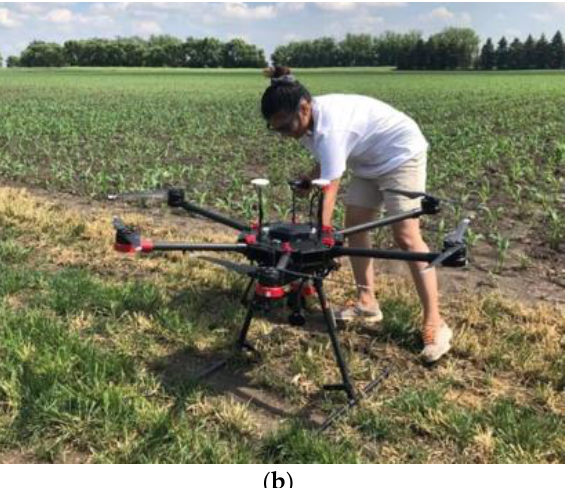
Figure 2. Harvesting of forage for biomass yield in Beresford ( a ); preparation for drone flight ( b ).